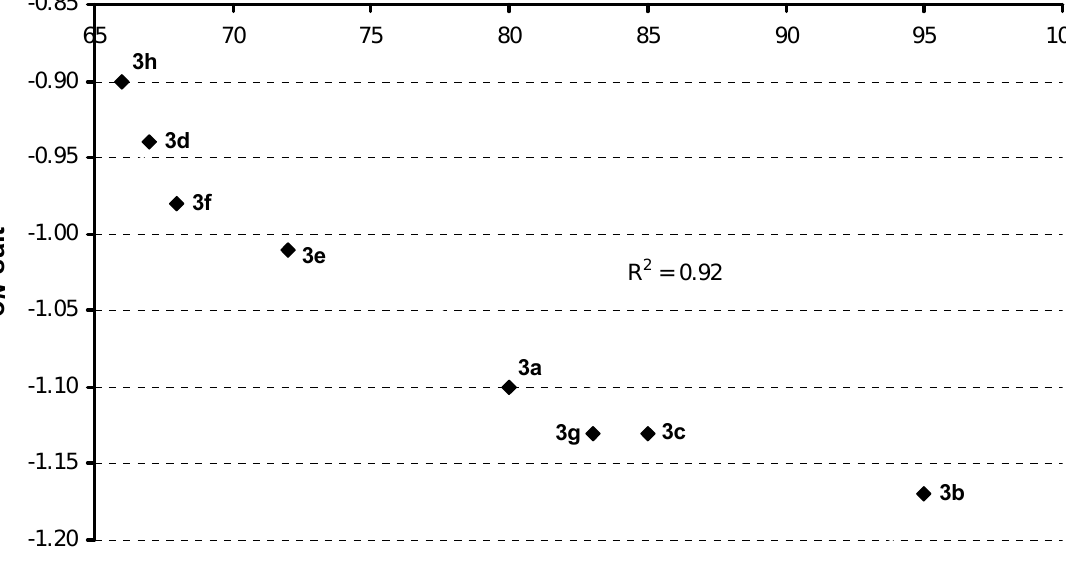
Figure 1. Correlation between experimental (Method B) and calculated data ( δ